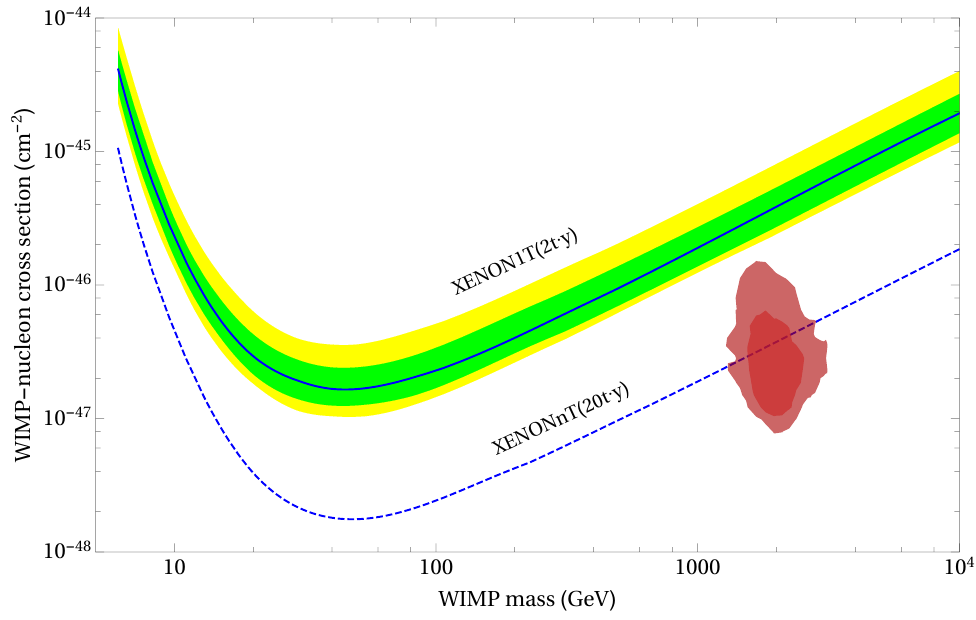
Figure 2 . XENON1T and XENONnT sensitivities to spin-independent WIMP-nucleon interaction as a function of the WIMP mass, shown as solid and dashed blue line. The green and yellow bands represent the 1 (cid:27) and 2 (cid:27) sensitivities of XENON1T [37] and the dark and light red regions are the 1 (cid:27) and 2 (cid:27) HPD regions of the MCMC analysis of our model. The WIMP is the LSP, which is the lightest neutralino.